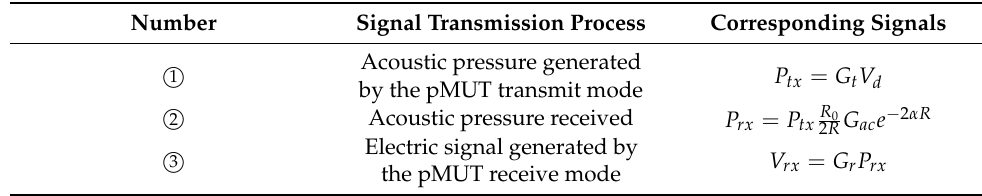
Table 1. The signal form alternation during the signal propagation process. Number Signal Transmission Process Corresponding Signals Acoustic pressure generated 1 (cid:13) by the pMUT transmit